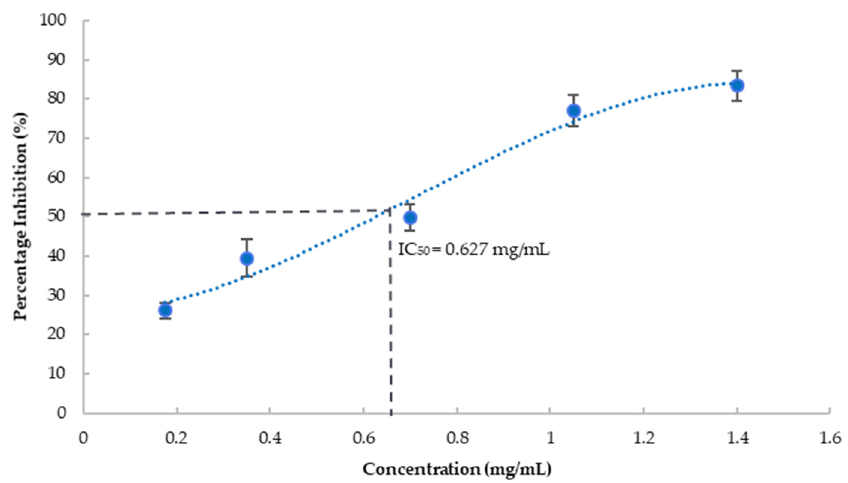
Figure 2. Percentage inhibition of tyrosinase by blueberry extract at various concentrations. Values are presented as the mean ± SD of n = 6.